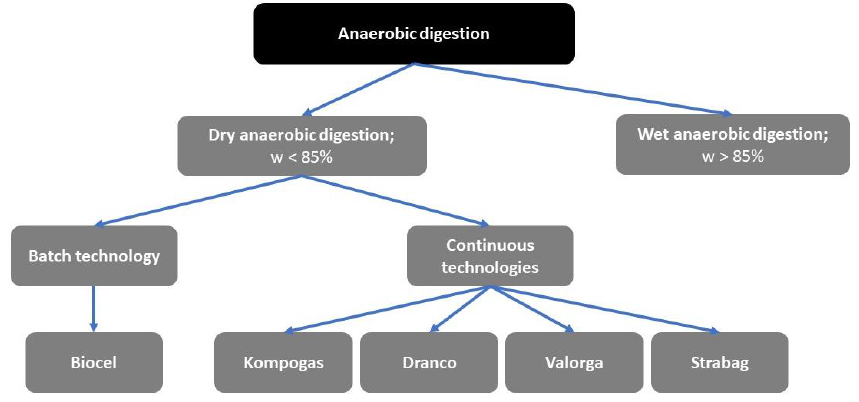
Figure 4. Dry AD reactors available in the market.